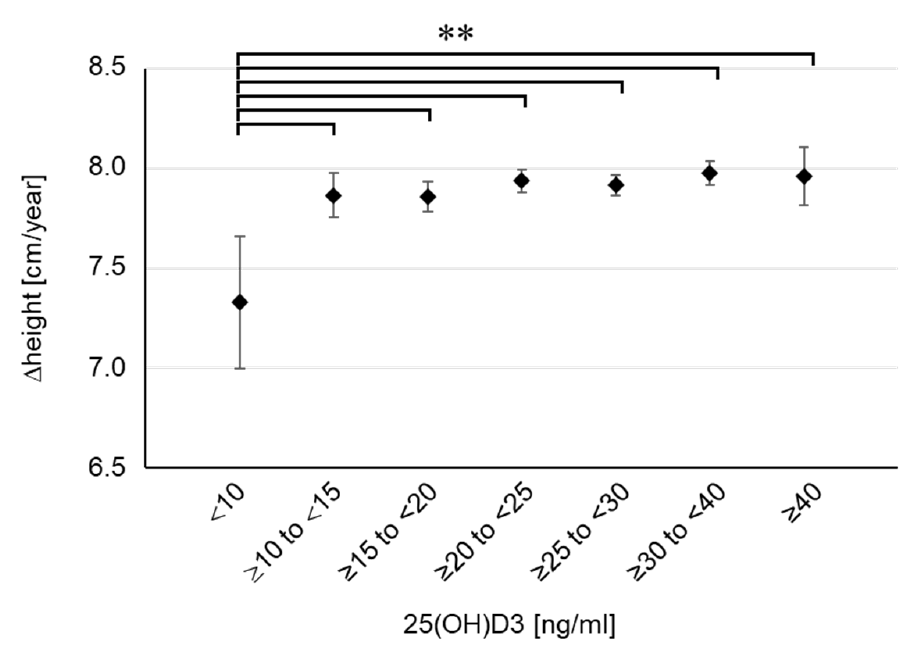
Figure 3. Height growth for each group divided by serum 25(OH)D3 concentration. Δheight means the height growth per year (12 months). Data are shown as mean and 95% CI. ** p < 0.01. Next, we investigated the frequency of exposure to sunlight to determine the cause of the low 25(OH)D3 concentrations. Using the questionnaire sent out at 4 years of age, we conducted an analysis on the time spent playing outside in both summer and winter, and the frequencies of wearing a hat and using sunscreen. The results are shown in Table S2 (online only). In all groups, the frequency of wearing a hat in summer was as high as 80% or more, for which there was no clear difference among the groups. Similarly, the frequency of using sunscreen in summer was 20–30%, for which there was no clear difference among the groups. However, when the total time spent playing outside was determined, it tended to be inversely proportional to the serum 25(OH)D3 concentration. About 30% of children in the lowest 25(OH)D3 group spent <1 h playing outside in the summer, compared with about 20% in the other groups (Figure 4 and Table S2). The difference in time spent playing outside among the groups increased in winter, and a significant difference was found between the groups with 25(OH)D3 < 25 ng/mL and the groups with 25(OH)D3 > 30 ng/mL (Figure 4B). In the lowest group, >60% of participants answered that they spent <1 h playing outside. These results are consistent with previous findings showing that time spent with exposure to sunlight affects the serum vitamin D concentration [1,26]. Interestingly, the results suggested that differences in sun exposure during winter may have a greater effect on the decline in